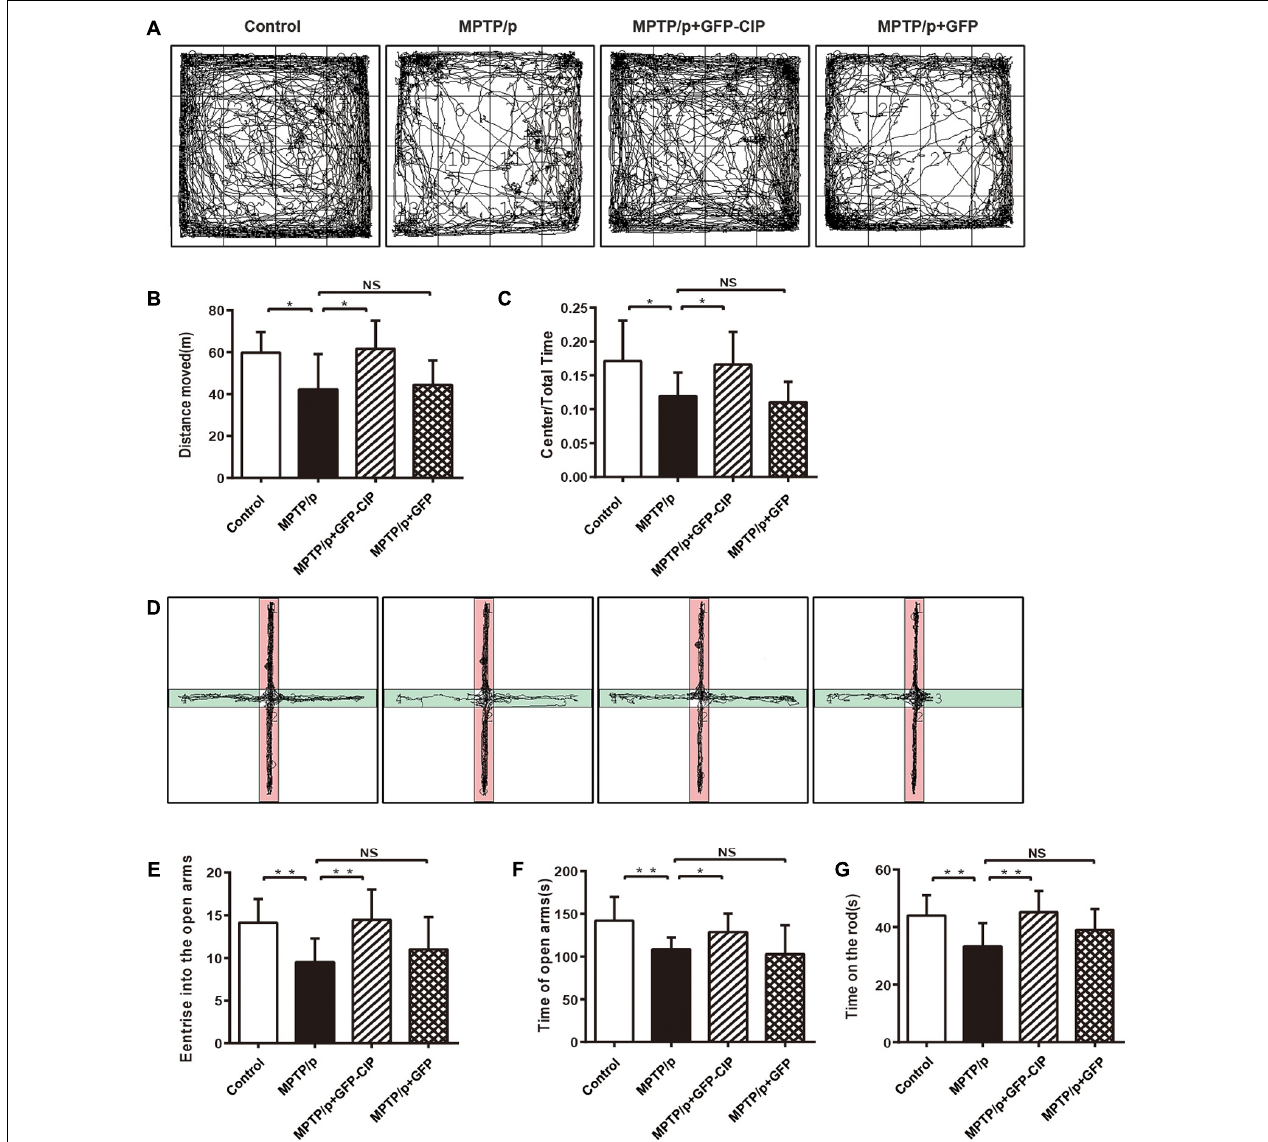
FIGURE 4 | AAV9-GFP-CIP alleviated motor and non-motor symptoms in MPTP/p induced mouse model. Forty-eight mice were randomized into four treatment groups with 12 mice in each group. At the checking point, one mouse died in PBS or GFP group. (A) The track of different group mice in open field test was recorded for 30 min. (B) The total traveled distance of mice in each group in open field test. Total traveled distance of PBS group (42.25 ± 5.65) was shorter than the control group (59.75 ± 3.16, ∗ p < 0.05). Total traveled distance of CIP group (61.68 ± 4.25) was longer than PBS group ( ∗ p < 0.05) and there was no different between PBS group and GFP group, labeled NS. (C) The ratio of central distance of mice in each group in open field test. The ratio of central distance of PBS group decreased significantly, when compared with control group ( ∗ p < 0.05). The ratio of central distance of CIP group was higher than PBS group ( ∗ p < 0.05) and there was no different between PBS group and GFP group, labeled NS. (D) The track of four groups of mice in elevated plus maze was recorded for 5 min. (E) The times of each mouse entering the open arms in the elevated plus maze test. Mice of control group (14.10 ± 0.89) and CIP group (14.44 ± 1.18) entered the open arms more frequently, when compared with PBS (9.500 ± 0.98) and GFP (11.00 ± 1.19) groups ( ∗∗ p < 0.01). (F) The duration of the mouse traveled in open arms. Mice of control group (141.9 ± 8.83) and CIP group (128.6 ± 7.20) spent more time in open arms when compared with PBS (108.6 ± 4.76) and GFP (102.7 ± 10.70) groups ( ∗ p < 0.05). (G) The time of each mouse maintained on the rod was recorded. The graph shows the latency of mice falling off the rod. Mice in the CIP group (115.5 ± 6.93) maintained longer than in the PBS (86.17 ± 8.3) and GFP (96.33 ± 9.36) groups ( ∗∗ p < 0.01). There was no difference between the control group (134.7 ± 12.06) and CIP